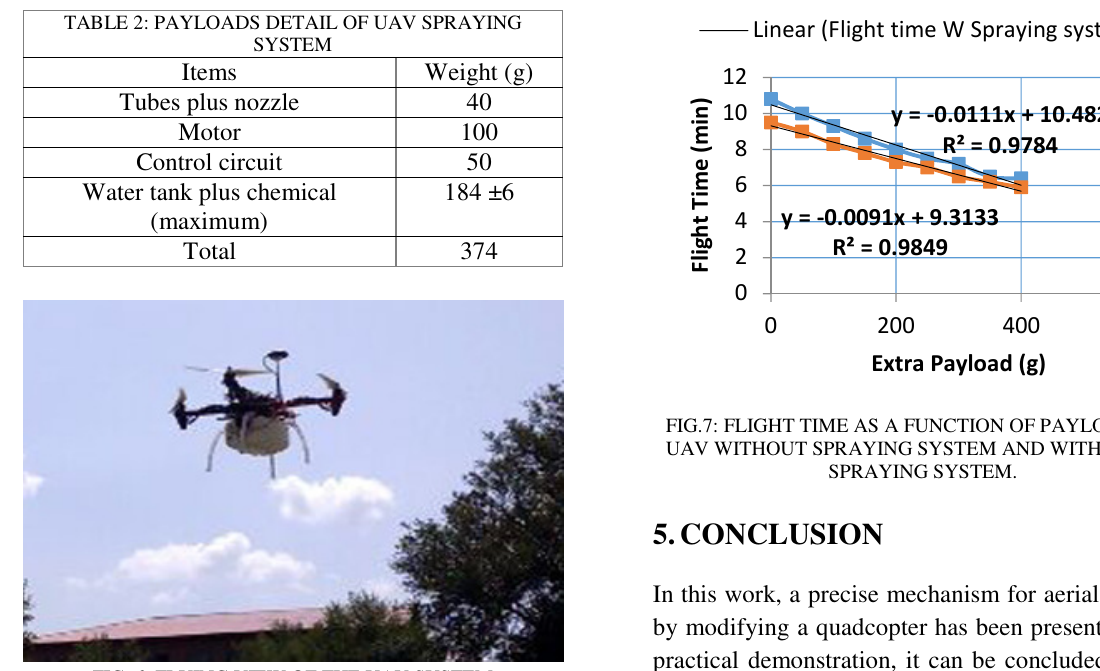
FIG. 6: FLYING VIEW OF THE UAV SYSTEM